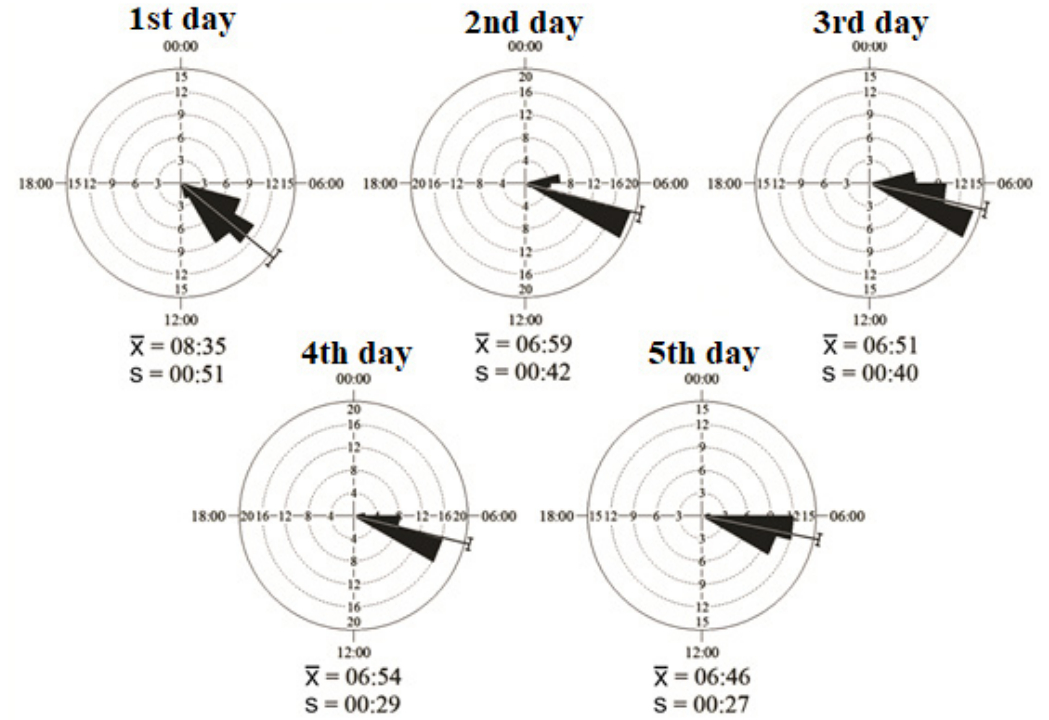
Fig 1 . Time of the first visit of M. subnitida foragers to an artificial feeder on each experimental day. The length of the sections indicates the number of bees in the corresponding time range. The radial line indicates the average time of the first occurrence (  ) and the line perpendicular to this indicates the circular standard deviation ( S ).